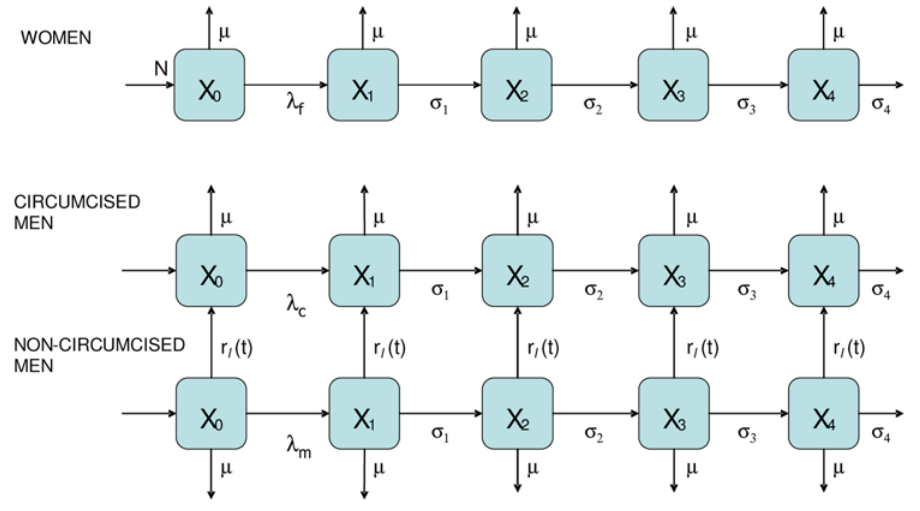
Figure 1. Flow diagram of model. The model population is divided into females, circumcised males and non-circumcised males. In each group, X 0 is the number of individuals not infected, X 1 is the number with acute HIV infection, X 2 is the number with latent infection, X 3 is the number of people in a stage shortly prior to AIDS and X 4 is the number with AIDS. The rate of progression between these stages of infection is given by s 1 , s 2 and s 3 and the rate of death for those with AIDS is s 4 ; on average, individuals have acute infection for four months, latent infection for eight years, ‘pre-AIDS’ for twelve months and AIDS for six months. The rate of incidence among females, circumcised and non-circumcised men are represented by l f , l c and l m respectively. The intervention is simulated by moving non-circumcised men into the group of circumcised men, at a rate which can be different for men who are infected from those who are not or different in the different sexual activity groups (not shown): r s ( t